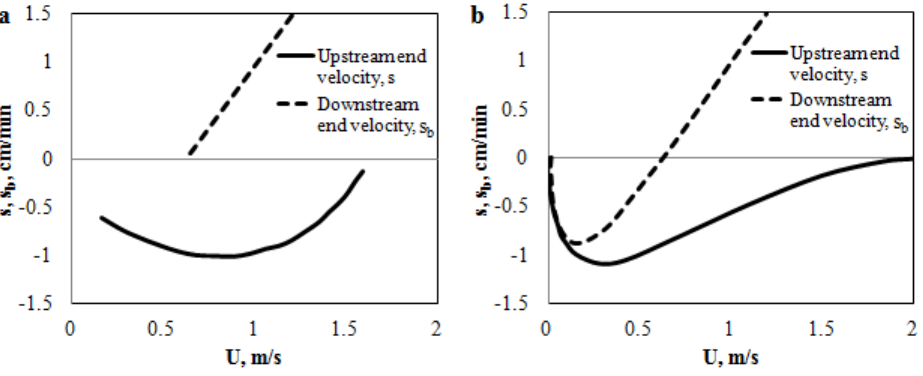
Figure 35. Dependence of burn velocity on the air flow rate [72]: ( a ) experimental data from Skafa [20], and ( b ) calculated data from Saulov et al. [72].